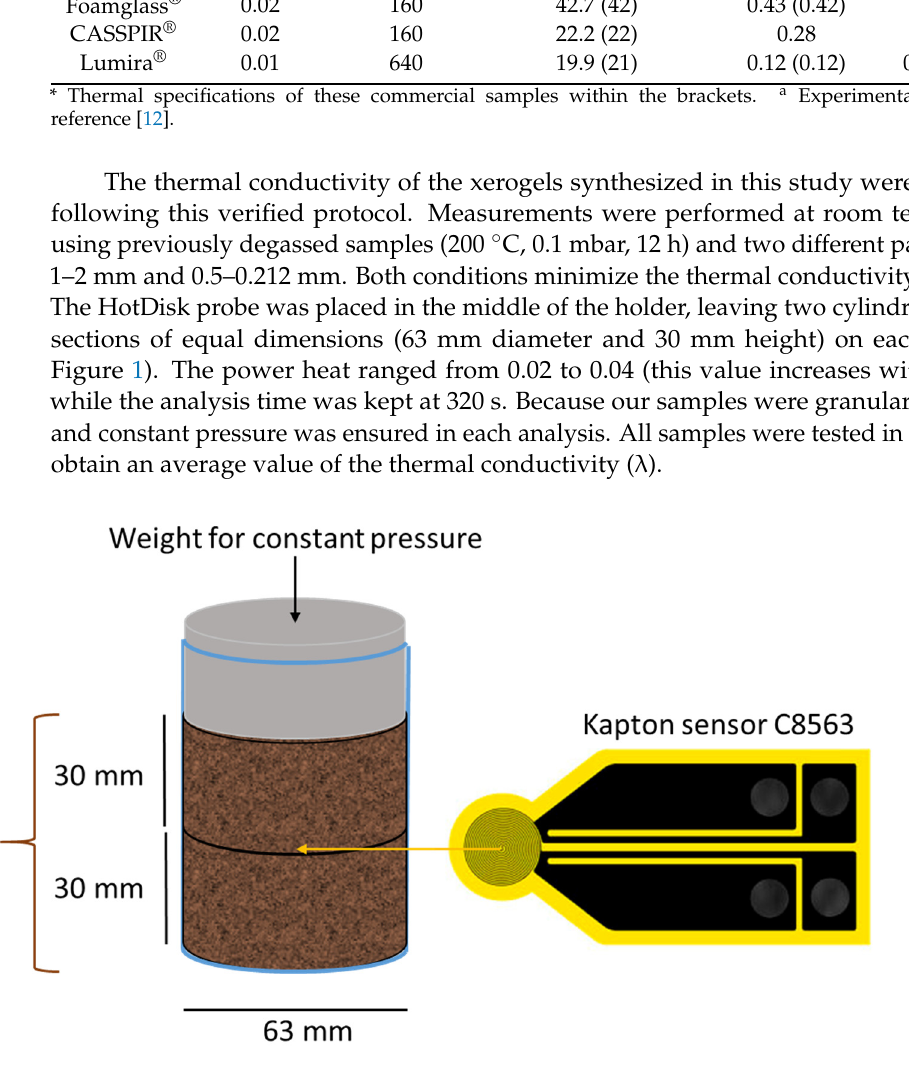
Figure 1. Configuration of the system for thermal conductivity measurements.